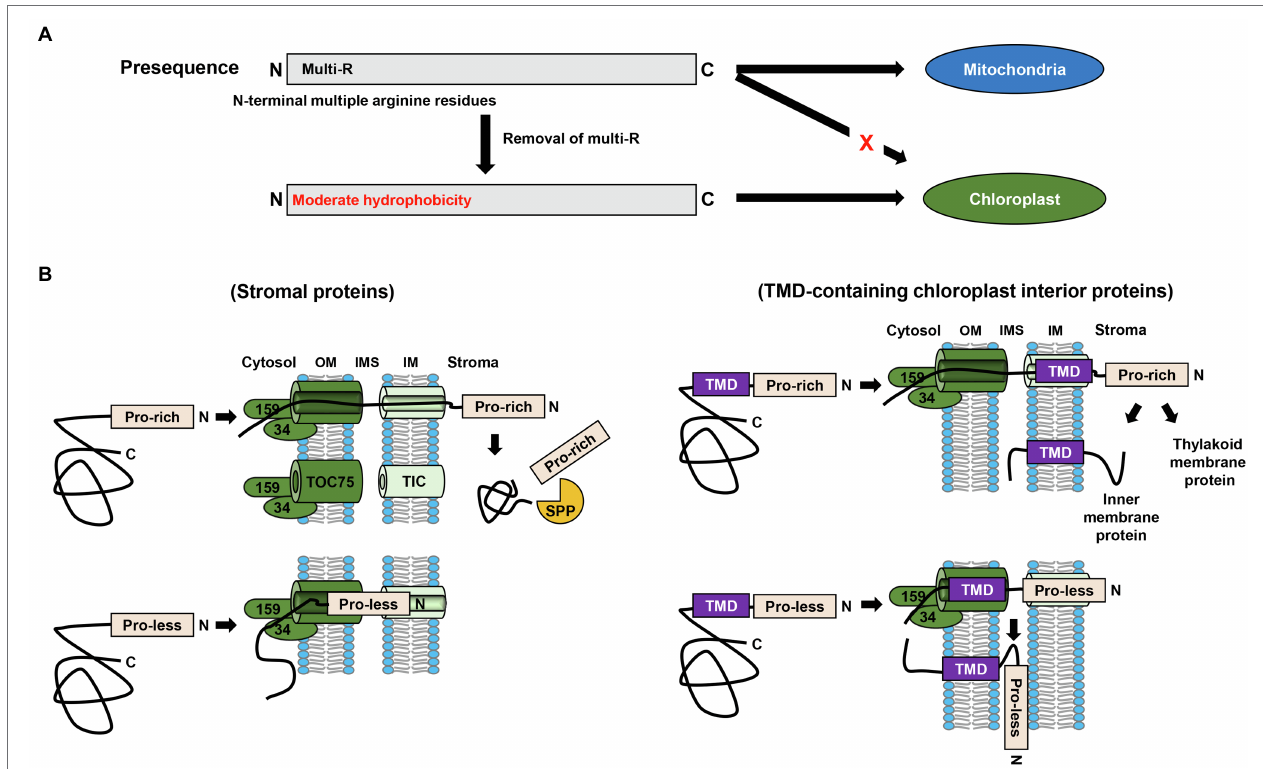
FIGURE 2 | Common characteristics of different transit peptides. (A) Multiple arginine residues in the N-terminal region of targeting signals function as a chloroplast evasion signal. Removal of the arginine residues from the N-terminal region of mitochondrial presequences is sufficient to switch the final destination of proteins from the mitochondria to chloroplasts. (B) Multiple proline residues in transit peptides are essential for preprotein translocation into chloroplasts. In the case of soluble stromal proteins, preproteins with proline-less transit peptides are trapped within the TOC/TIC translocons, whereas for transmembrane domain (TMD)-containing chloroplast internal proteins, the preproteins are laterally inserted into the chloroplast outer membrane when the preproteins harbor proline-less transit peptides. TP, transit peptide; OM, outer membrane; IMS, intermembrane space; IM, inner membrane; TMD, transmembrane